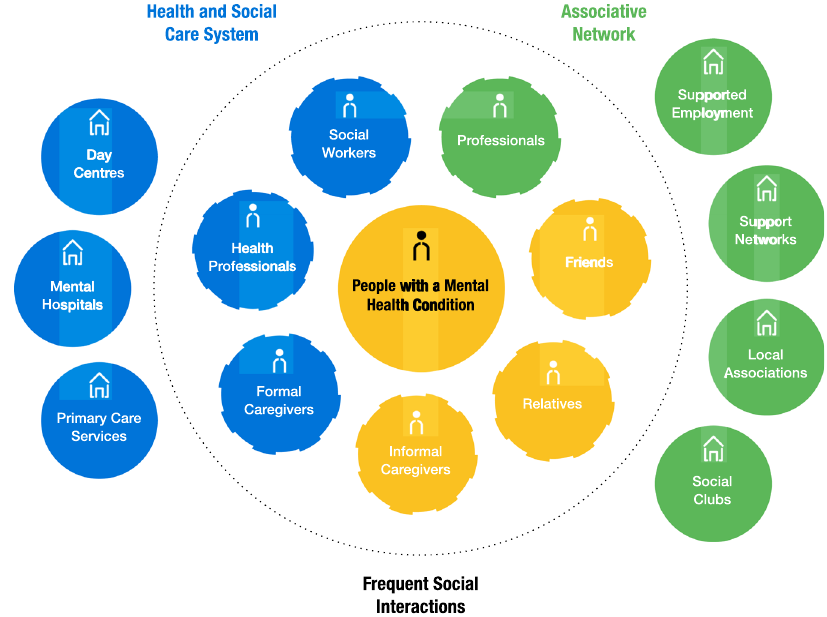
Fig. 2 Main actors within community-based mental health care model. The three main fi elds considered are (1) the health and social care system (in blue), (2) the associative network (in green) and (3) the frequent social interactions, represented in the inner-most circle around the persons (people) with mental health